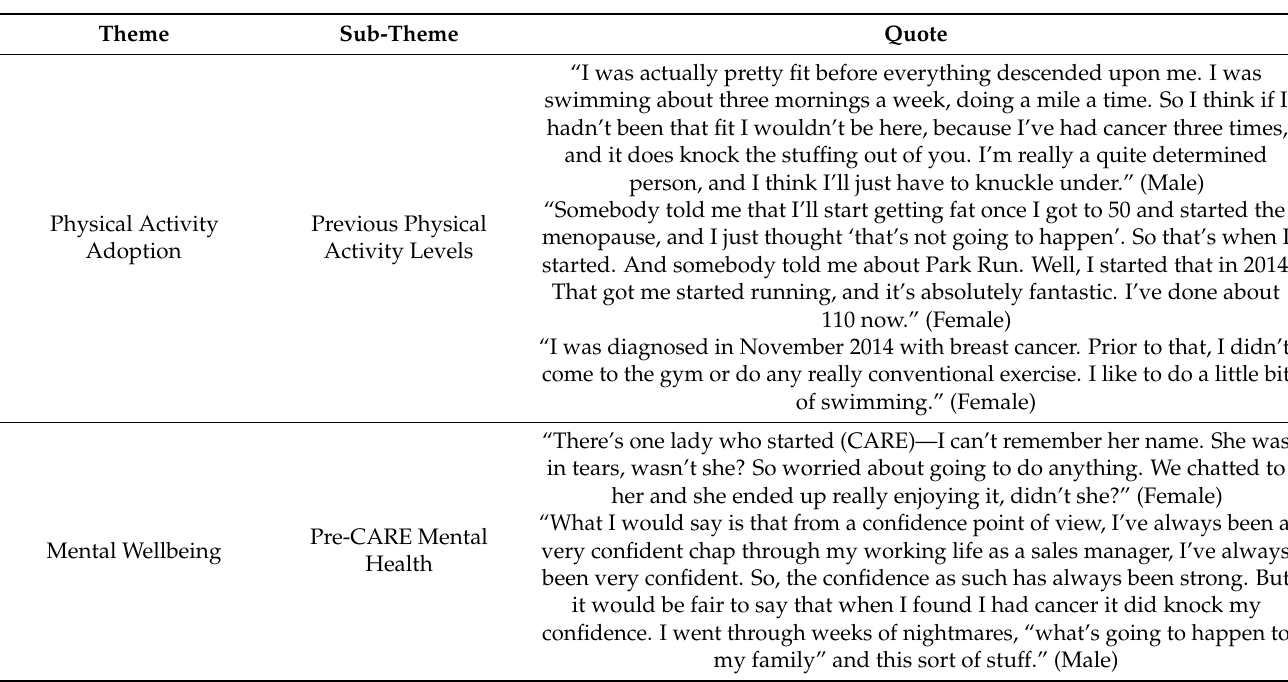
Table 7. Overall Adoption themes, sub-themes and participant quotes related to their experience of